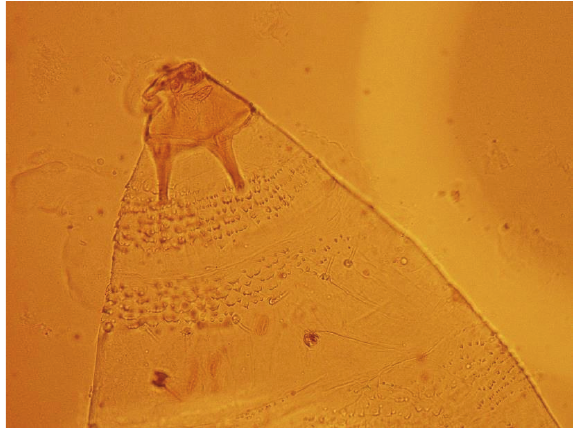
Figure 7: First instar, terminal abdominal segments showing haired papillae, the longest of which are those attendant to the spiracles.